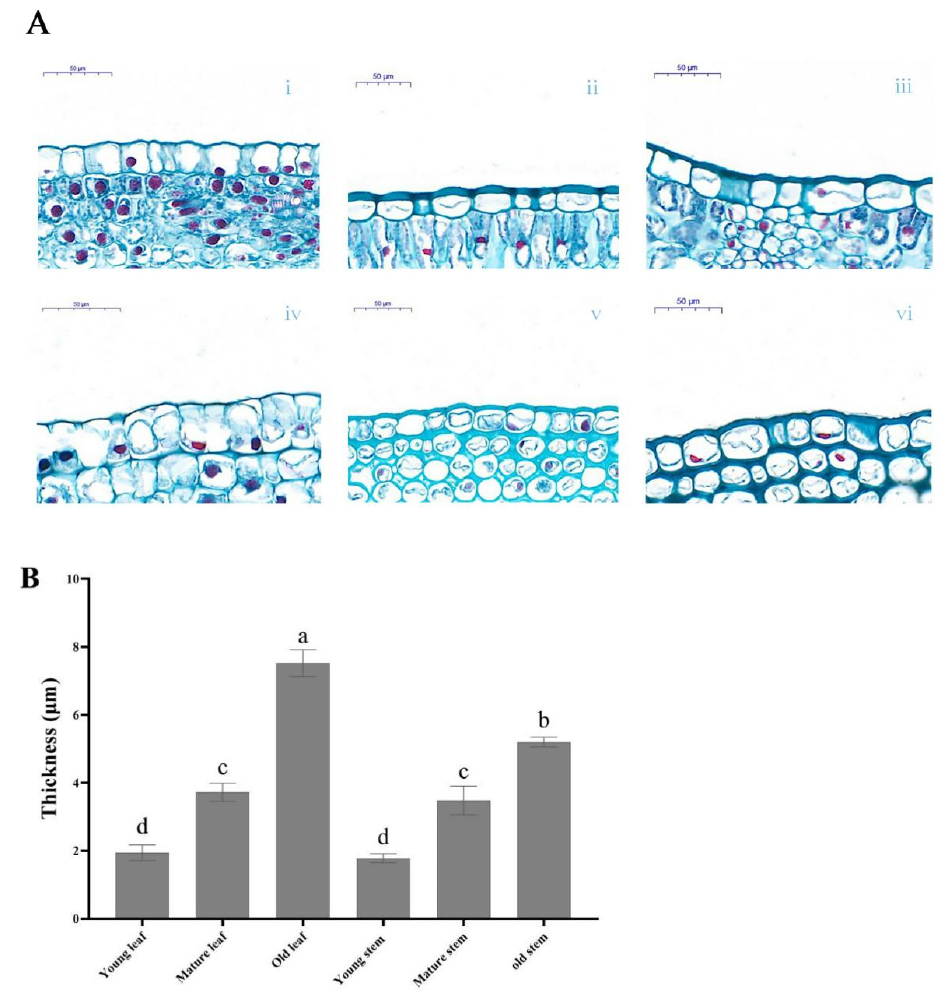
Figure 2. Microscopic observation of paraffin sections and thickness measurement from leaves and stems. ( A ) Paraffin section of leaves and stems. ( i ) Young leaf; ( ii ) mature leaf; ( iii ) old leaf; ( iv ) young stem; ( v ) mature stem; ( vi ) old stem. ( B ) Cuticle thickness of leaves and stems. Bars show means ± SD with three biological replicates. Different letters on the graph indicate significant differences ( p < 0.05). The same as below.